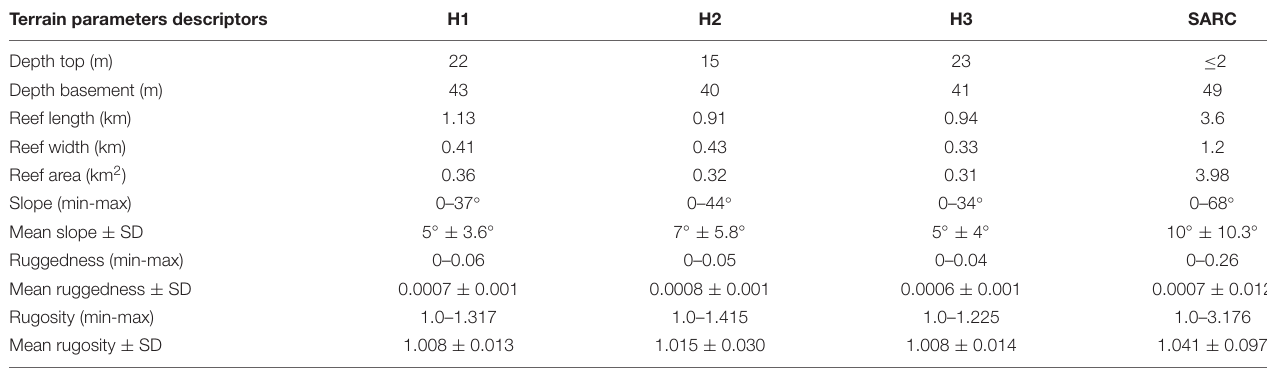
FIGURE 2 | Three-dimensional bathymetric models of H1 (A) , H2 (B) , and H3 (C) showing a northwest-southeast orientation view from above, the lateral view for maximum length and the lateral view for minimum length; the green arrow points North. Vertical exaggeration 8x. TABLE 2 | Terrain parameters descriptors for each individual reef in the Holandesas group, and the SARC: depth basement (m), depth top (m), reef length (km), reef area (km 2 ), slope (minimum-maximum), mean slope and standard deviation (SD), ruggedness (minimum-maximum), mean ruggedness (SD) rugosity (minimum-maximum), and mean rugosity